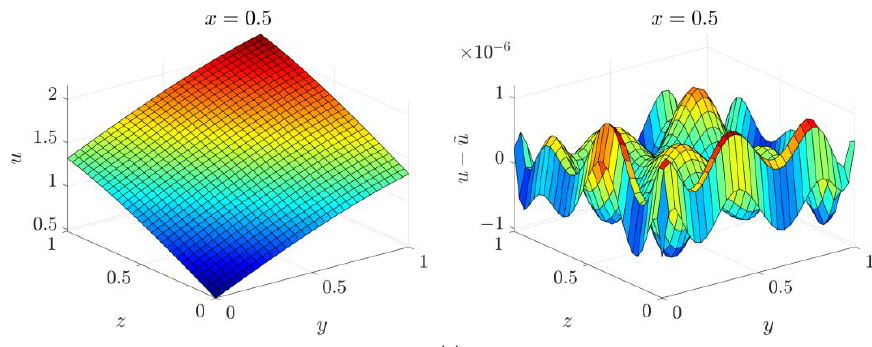
Figure 21. Solution and corresponding error for the 3D parameter identification problem in cubic domain under different discretizations: ( a ) N s = 7 × 7 × 7; ( b ) N s = 9 × 9 × 9; ( c ) N s = 11 × 11 × 11.